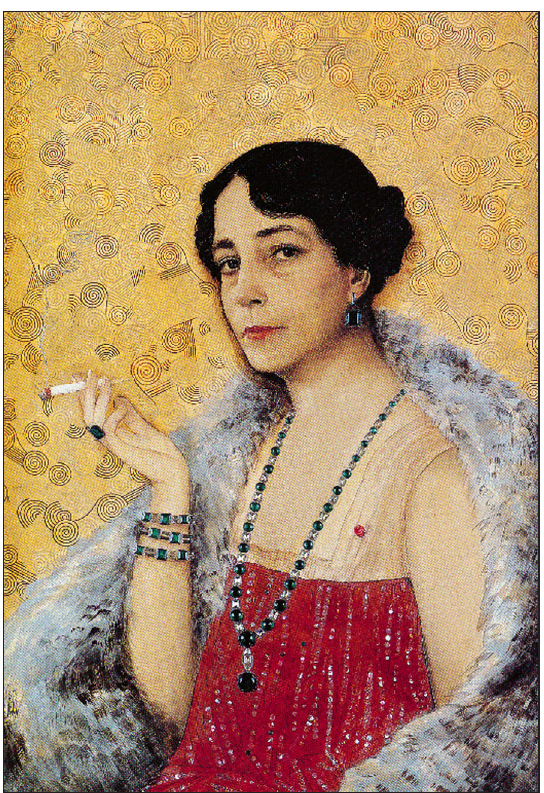
Fig. 8 : Jean Dunand, Portrait of Florence Blumenthal , Paris, 1927, oil on canvas, 78 × 54 cm, private